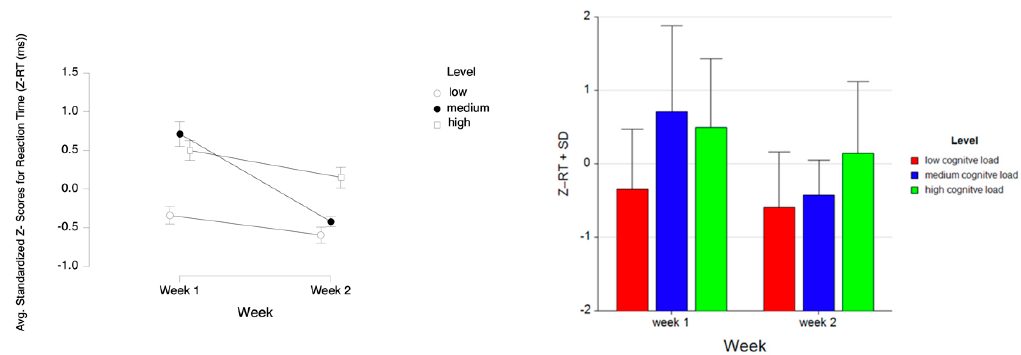
Figure 9. Line plot (left) represents interaction effect of Level and Week on average standardized z scores for reaction time (Z-RT) with the error bars representing the standard error of the mean statistic. Bar chart (right) represents average standardized z-scores for Z-RT and standard deviation (SD) for low cognitive load, medium cognitive load, and high cognitive load tasks for Week 1 and Week 2.